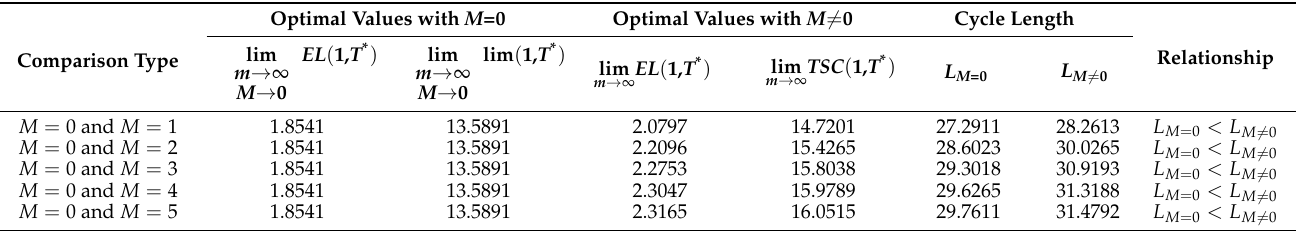
Table 5. Illustration of the CRR